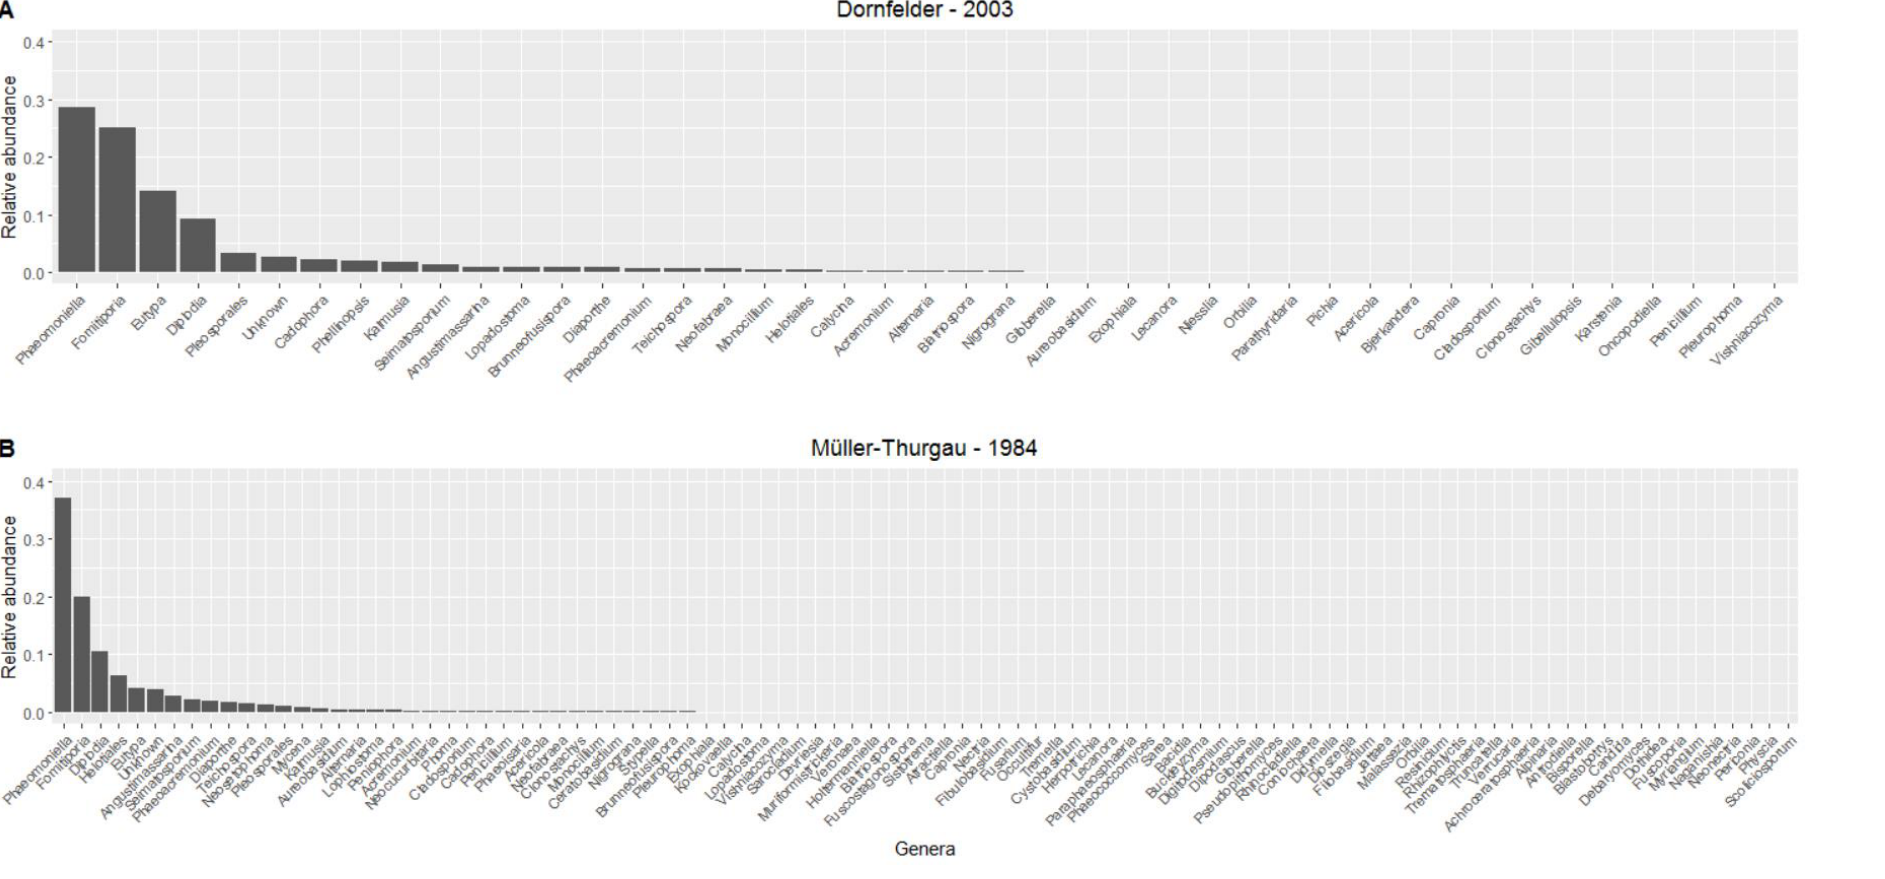
Figure A1. Overall relative abundance of the fungal genera identified by metabarcoding of 72 grapevine wood samples taken from ( A ) ‘Dornfelder’ and ( B ) ‘Müller-Thurgau’ vineyards, respectively.